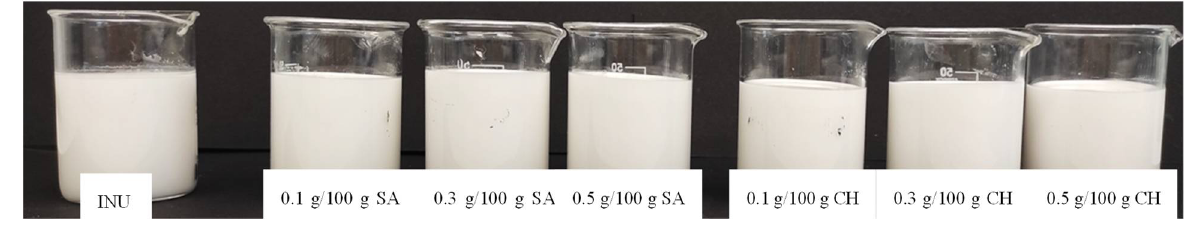
Figure 4. Sample photos showing the color of inulin gels obtained without and with various SA and CH concentrations.